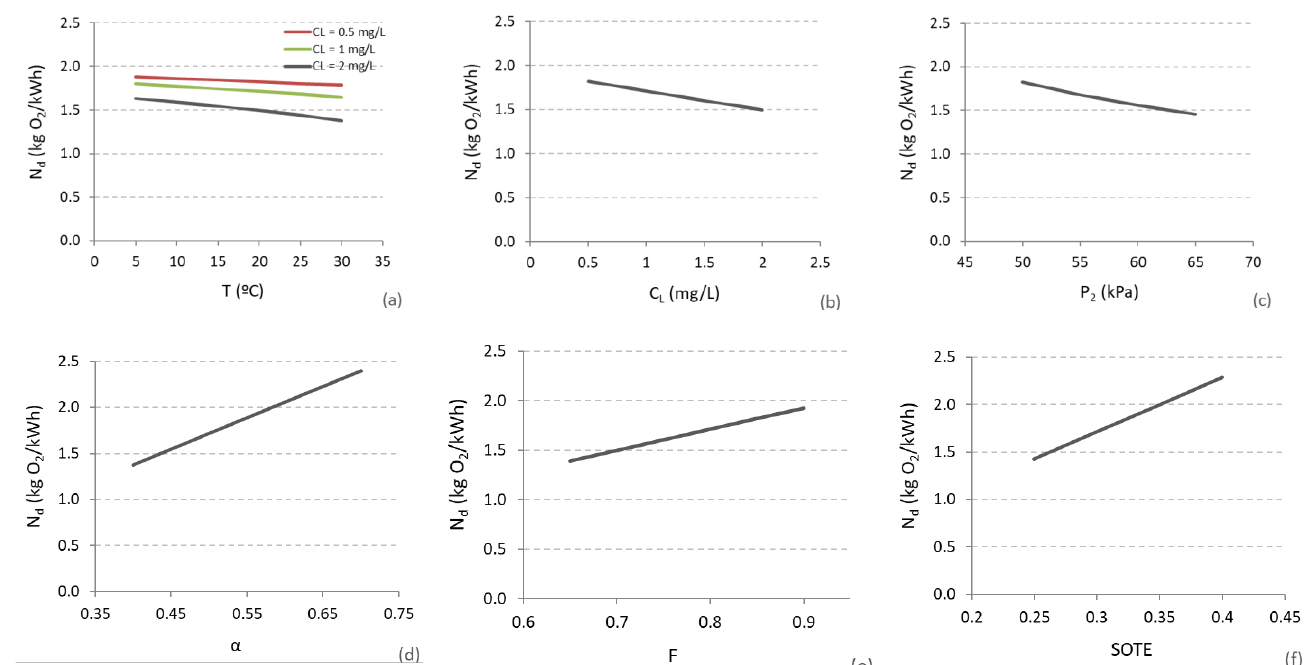
Figure 4. Oxygen transfer by air diffuser systems vs. temperature ( a ), operating oxygen concentration ( b ), outlet pressure ( c ), oxygen transfer correction factor α ( d ), fouling factor F ( e ), and SOTE ( f ) (considering, for the other parameters, their typical values in Table 13.